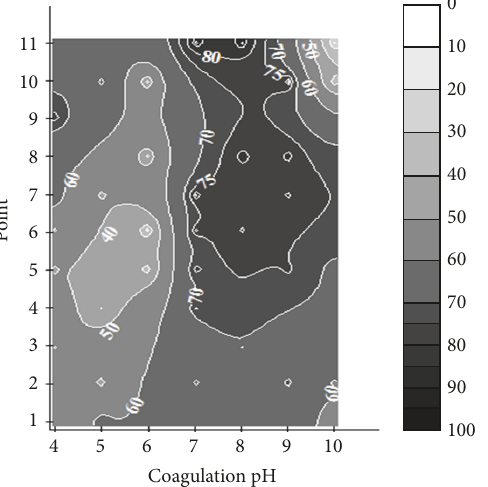
Figure 5: Coagulation diagrams with curves of turbidity removal in percentage (%).